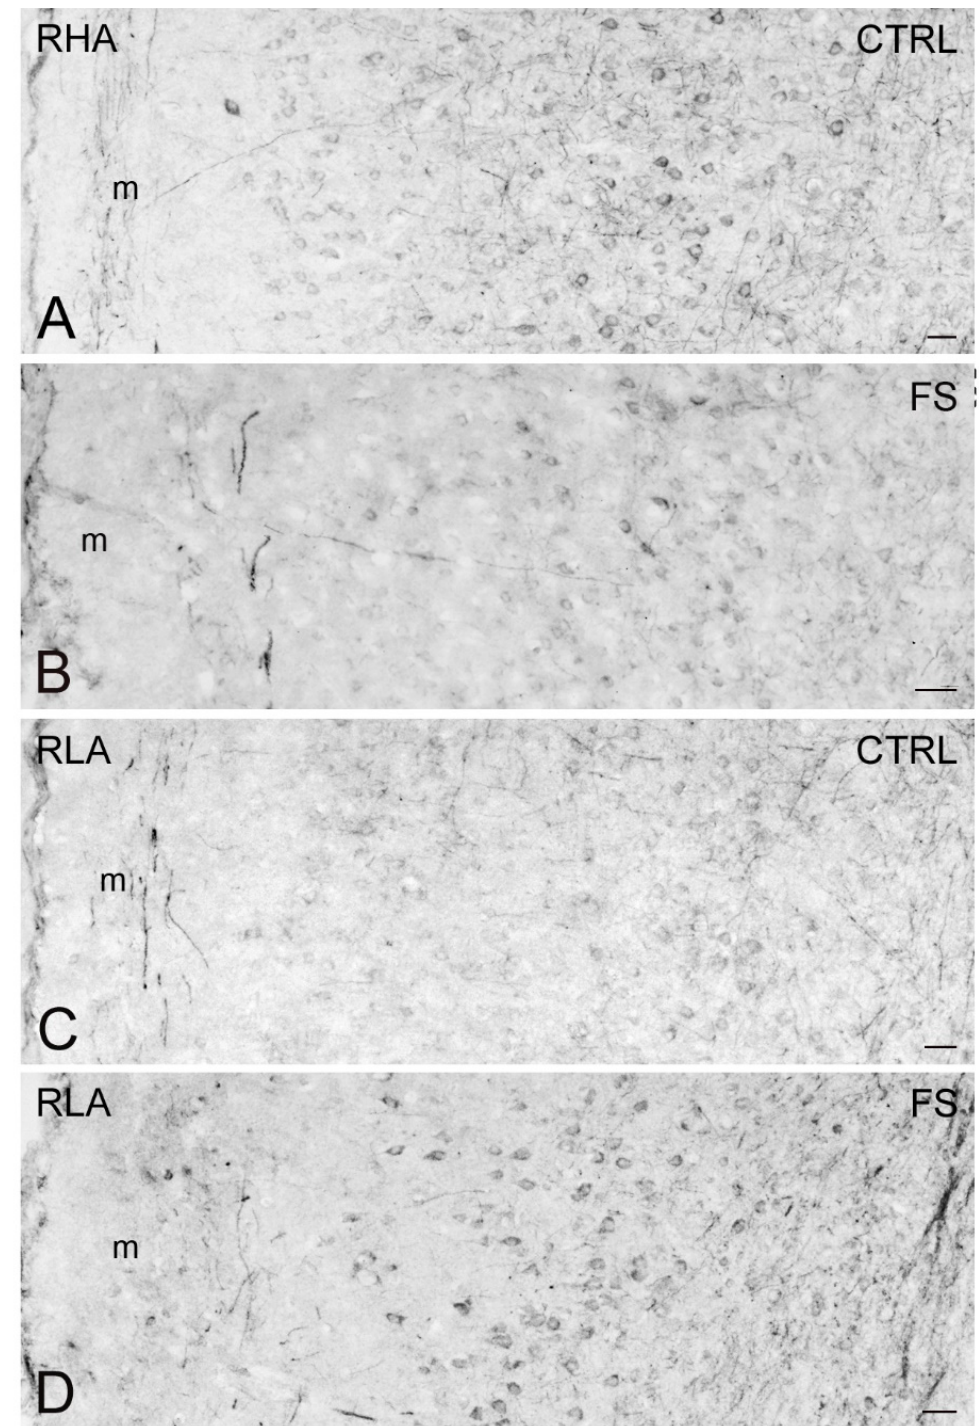
Figure 9. Brain-derived neurotrophic factor-like immunoreactivity (BDNF-LI) in the infralimbic (IL)/prelimbic (PL) region of the medial prefrontal cortex of RHA ( A , B ); and RLA rats ( C , D ) under baseline conditions (CTRL) and after a 15 min session of forced swimming (FS). m, molecular layer. Scale bars: 25 µm.